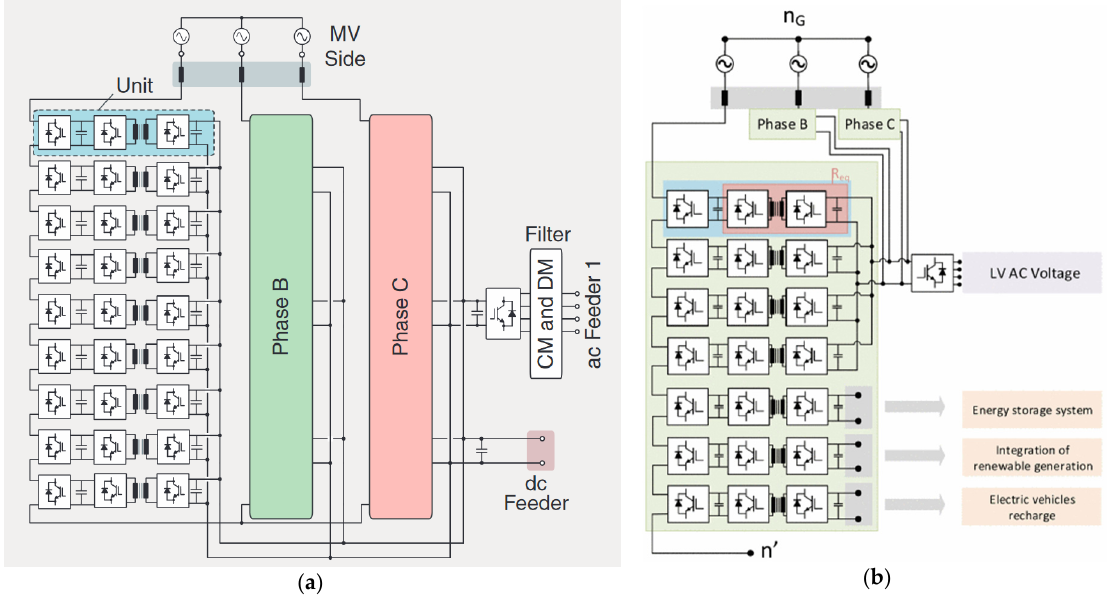
Figure 1. ( a ) Conventional topology of a three-phase smart transformer [1], ( b ) possible topology of a